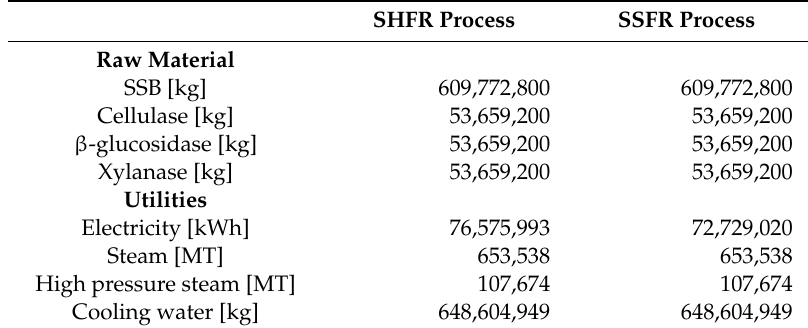
Table 1. Amount of raw materials (SSB and enzymes; per year) and utilities for production of butanol in the SHFR and SSFR processes (per year).